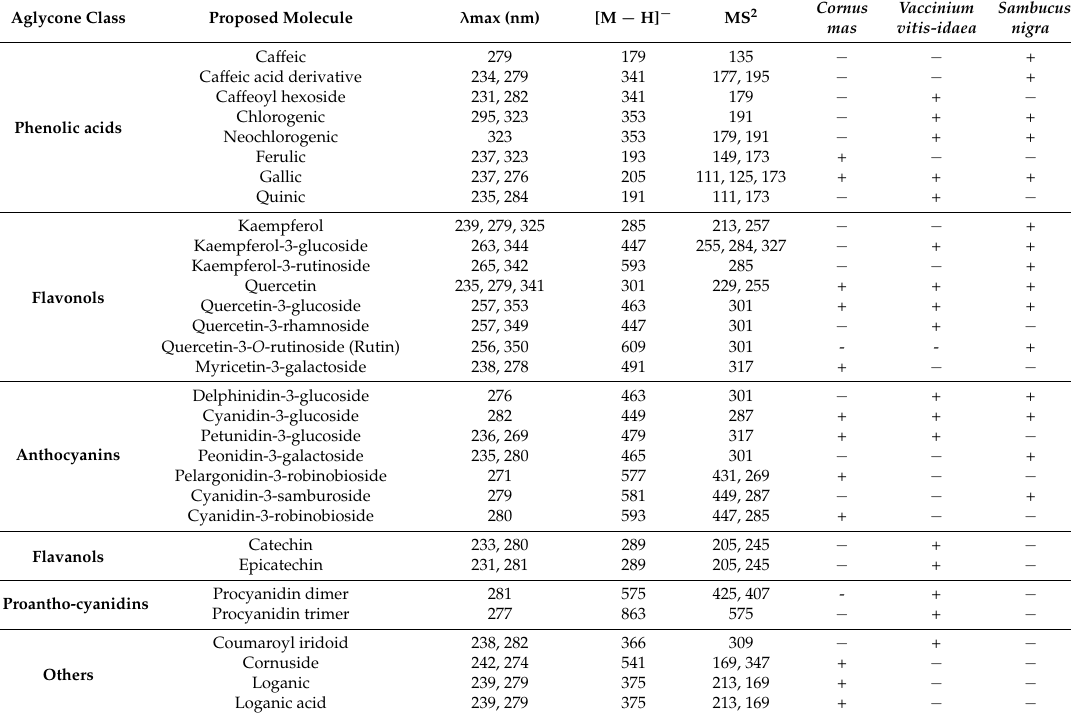
Table 3. Major polyphenolic compounds present in the tested juices, using the LC-MS